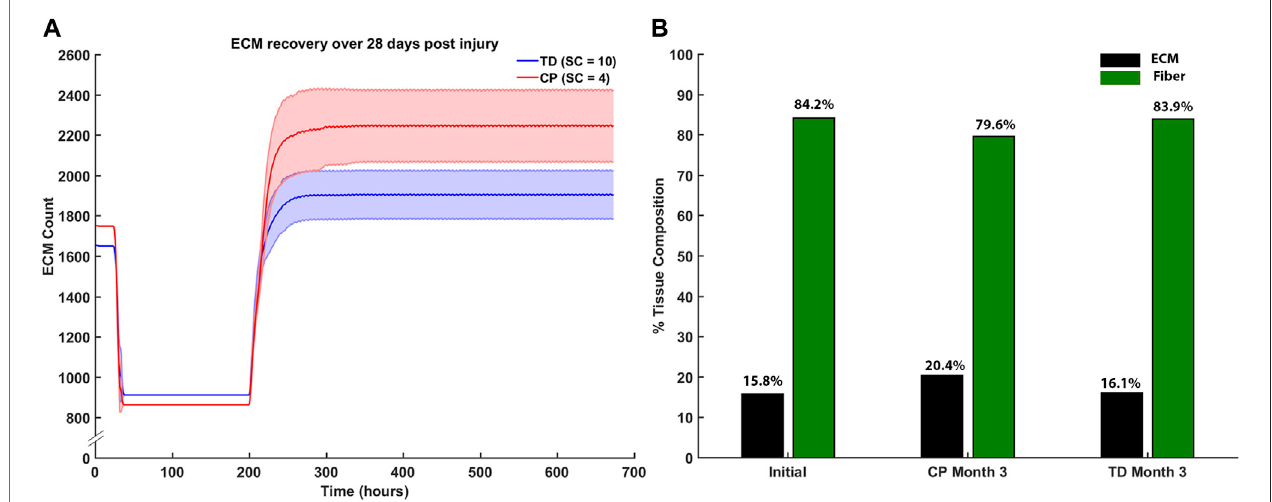
FIGURE 11 | (A) ECM recovery over the third month 28 days post injury simulation. CP muscle environment (SC (cid:2) 4) had higher end point ECM count of 2,240 ± 176 and the TD environment had a lower endpoint count of 1932 ± 139. (B) Tissue composition changed from initial simulations to the end of the third month. ECM percentage increased by 4.6% in the CP scenario and marginally increased by 0.3% in the TD